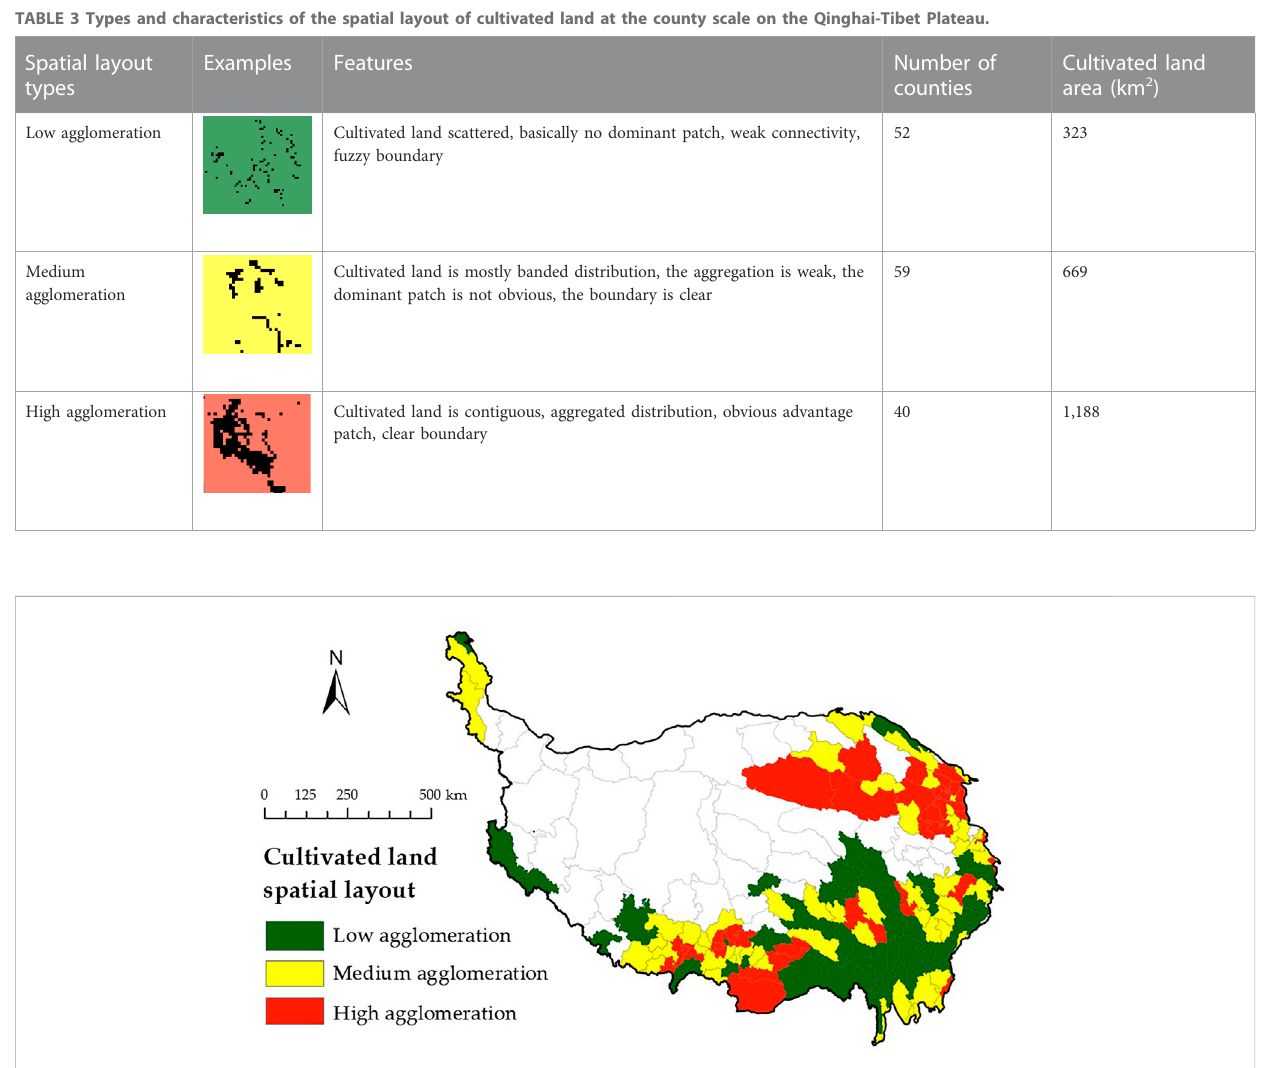
FIGURE 5 Spatial layout of cultivated land at the county scale on the Qinghai-Tibet